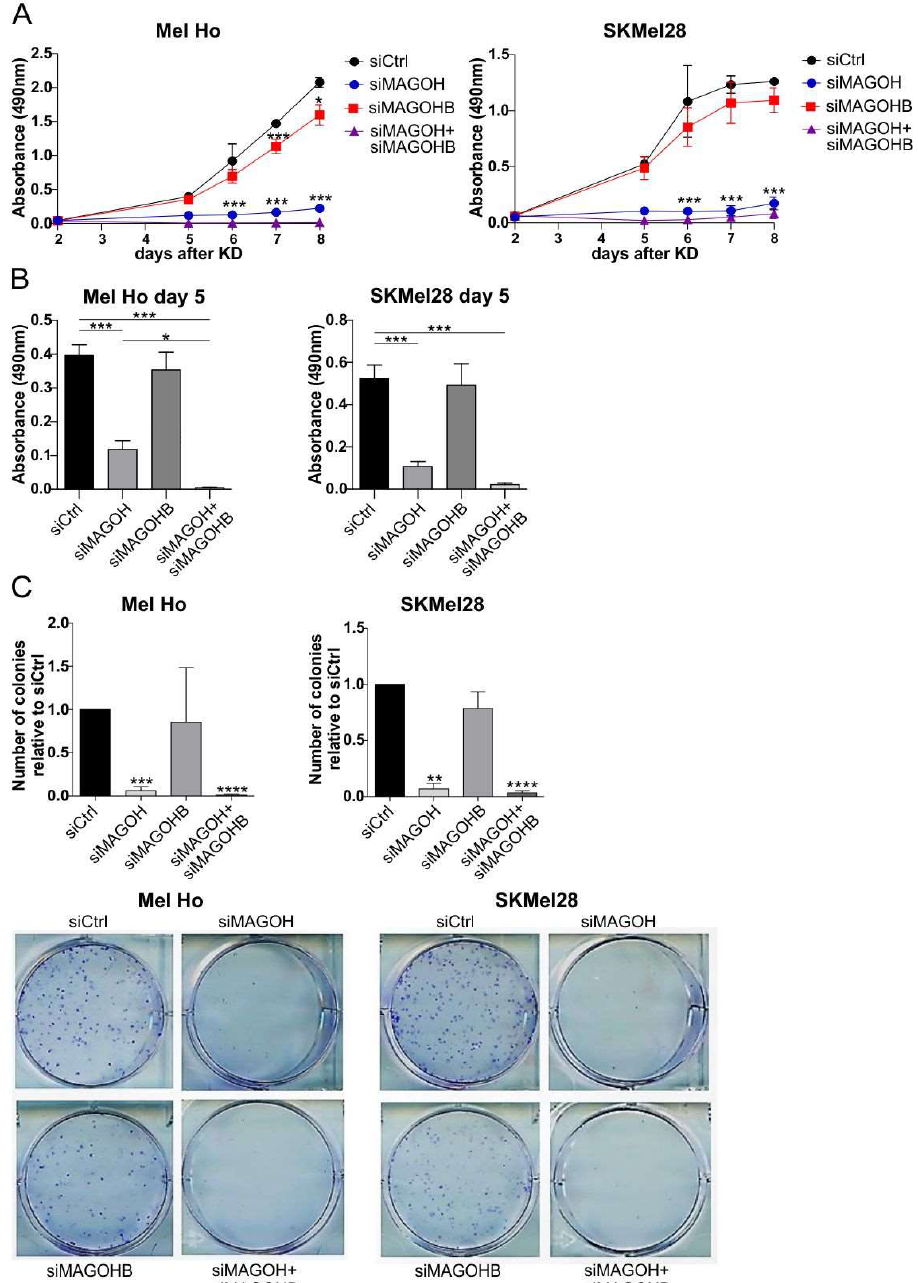
Figure 3. Knockdown of MAGOH, as well as of MAGOH and MAGOHB significantly inhibits cutaneous melanoma cell proliferation and clonogenicity. ( A ) The cutaneous melanoma cell lines Mel Ho and SKMel28 were transfected with siRNAs targeting MAGOH, MAGOHB and MAGOH + MAGOHB and the effect on cell proliferation was monitored compared to the siCtrl for eight days by measurement with an XTT assay. The graphs represent data from three independent experiments (mean ± SD, * = p < 0.05, *** = p < 0.001, one-way ANOVA with Tukey’s Multiple Comparison Test, the stars above the two bottom lines represent both samples, siMAGOH and siMAGOH + siMAGOHB) ( B ) Summary of Absorbance measurement of the XTT assay shown in A at day 5 (mean ± SD, n = 3, * = p < 0.05, *** = p < 0.001, one-way ANOVA with Tukey’s Multiple Comparison Test). ( C ) Clonogenic assay of Mel Ho and SKMel28 after KD of MAGOH and MAGOH + MAGOHB normalized to the siCtrl. Representative pictures of one experiment are shown, graphs depict data from three replicate analyses (mean ± SD, ** = p < 0.01, *** = p < 0.001 **** = p < 0.0001, one-sample t -test compared to